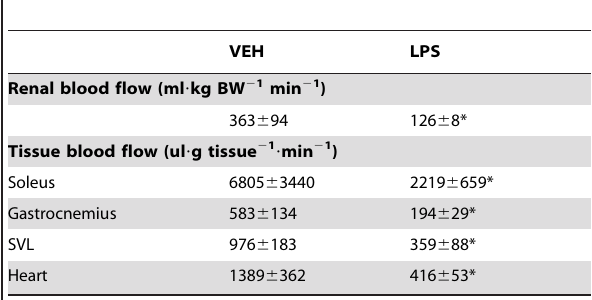
Table 2. Renal and tissue blood flow following vehicle or LPS treatment.